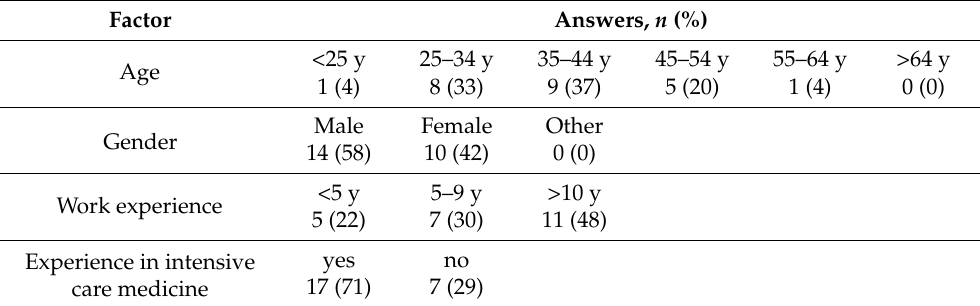
Table 2. Demographic data of study participants ( n = 24).